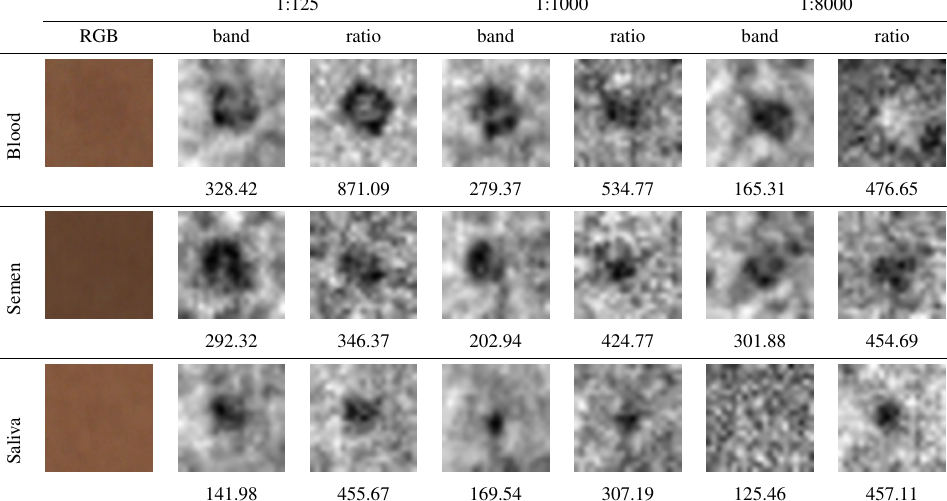
and F λ , respectively, given by i i